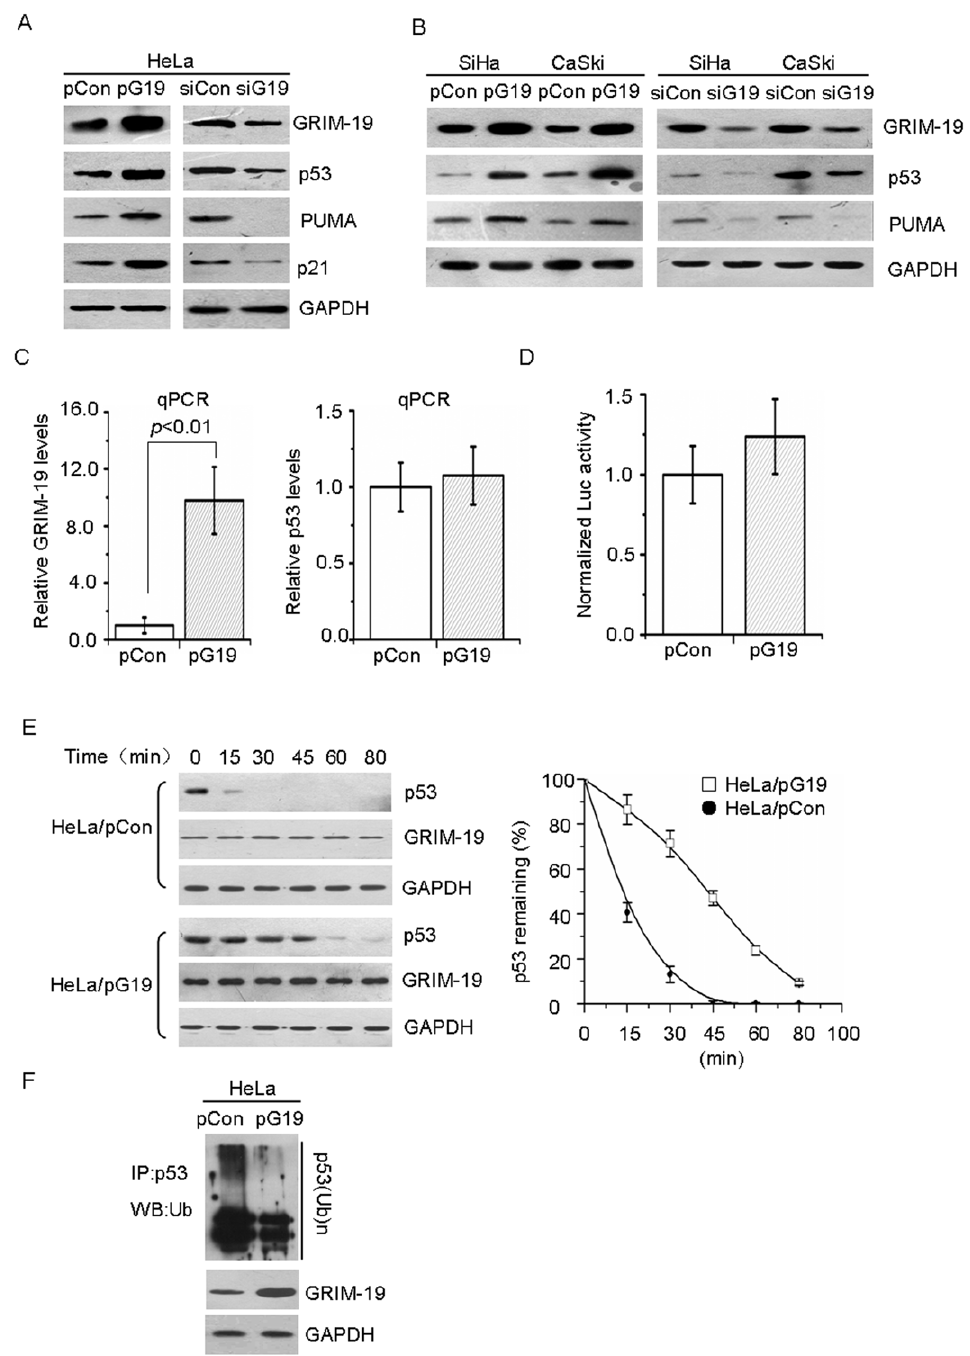
Figure 2. GRIM-19 induced p53 protein accumulation in HR-HPV infected cervical tumor cells. ( A & B ) The protein levels of GRIM-19 and p53 in primary cervical cancers. Western blotting with the indicated antibodies was performed using lysates from the indicated cell lines. ( C ) Effect of GRIM-19 on p53 mRNA expression. The mRNA of GRIM-19 (left panel) significantly high in HeLa/pG19 cells (* p , 0.01), the right panel shows p53 mRNA expression. Differences are not statistically significant. ( D ) GRIM-19 did not affect the p53-promoter activity. A p53-Luc reporter was used. The data presented are the mean of three independent experiments with triplicate samples in each test. ( E ) GRIM-19 increases the half-life of p53. Cells were treated with CHX (100 m g/ml) for the indicated time periods and lysates were subjected for Western blotting with the indicated antibodies. Representative results from one out of three independent experiments are shown (left panel). The remaining value for p53 was calculated as the ratio of the densitometric values of p53 over GAPDH in each sample (right panel). The average remaining values from three independent experiments were plotted. ( F ) GRIM-19 inhibited p53 degradation in vivo . Before harvesting the cells were treated with MG132 for 4 h, and immunoprecipitation with p53 antibody was performed. Western blotting of the IP products was using ubiquitin antibody. GAPDH antibodies were used to determine the comparable loading.